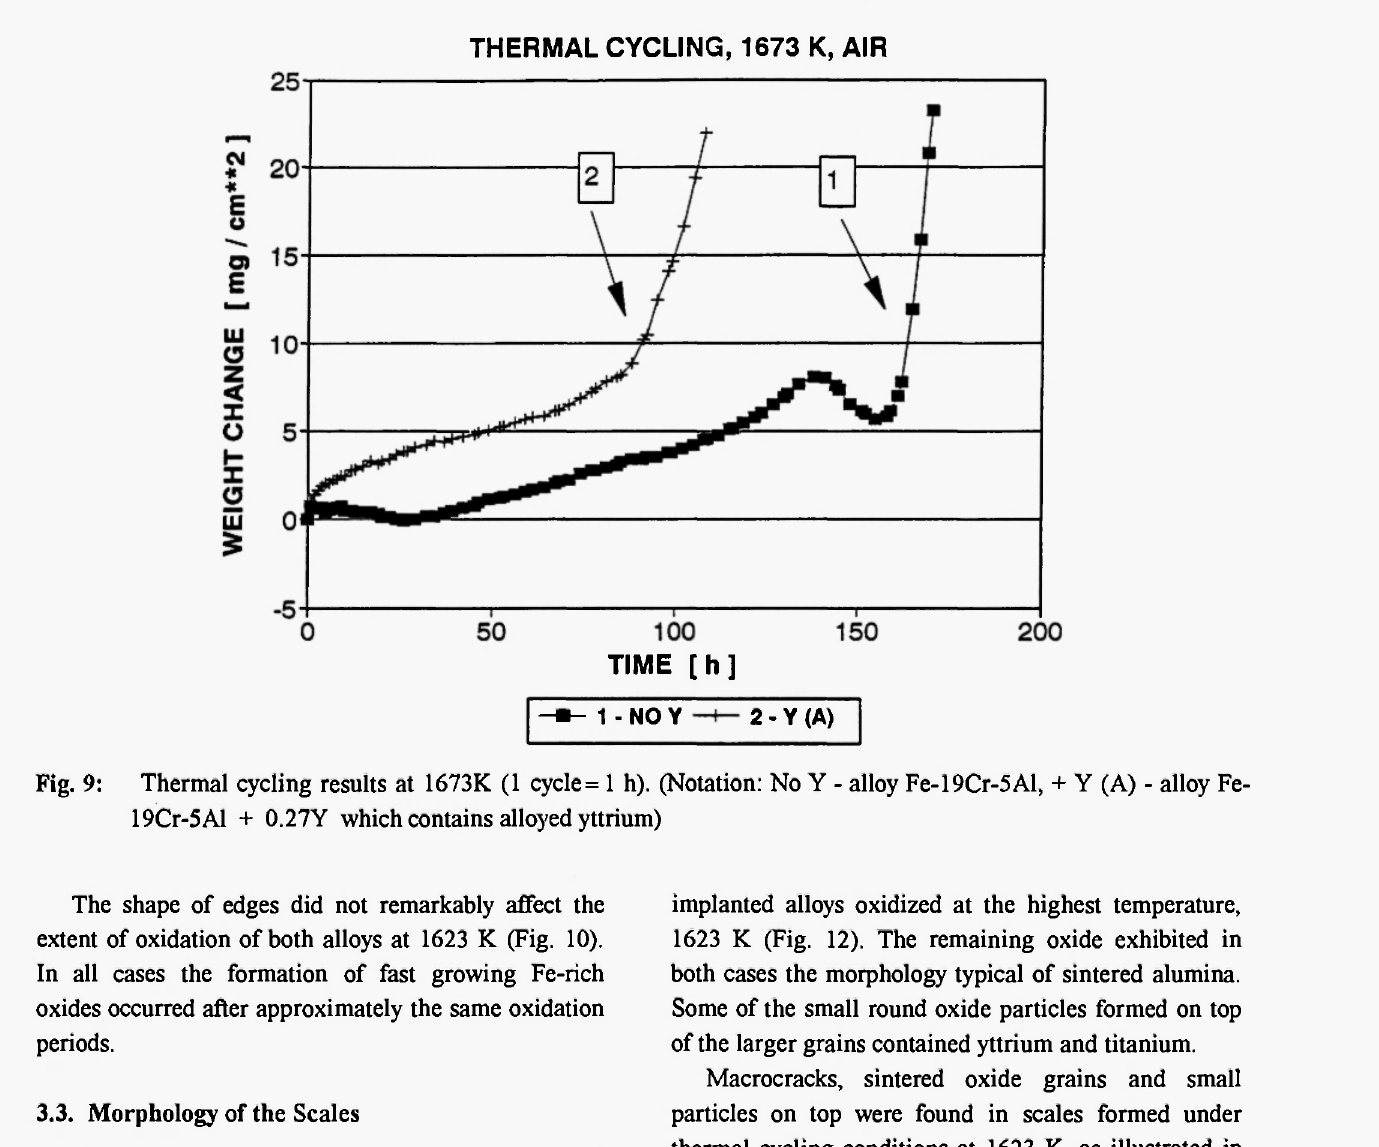
Fig. 9: Thermal cycling results at 1673K (1 cycle= 1 h). (Notation: No Y - alloy Fe-19Cr-5Al, + Y (A) - alloy Fe- 19Cr-5Al + 0.27Y which contains alloyed yttrium)